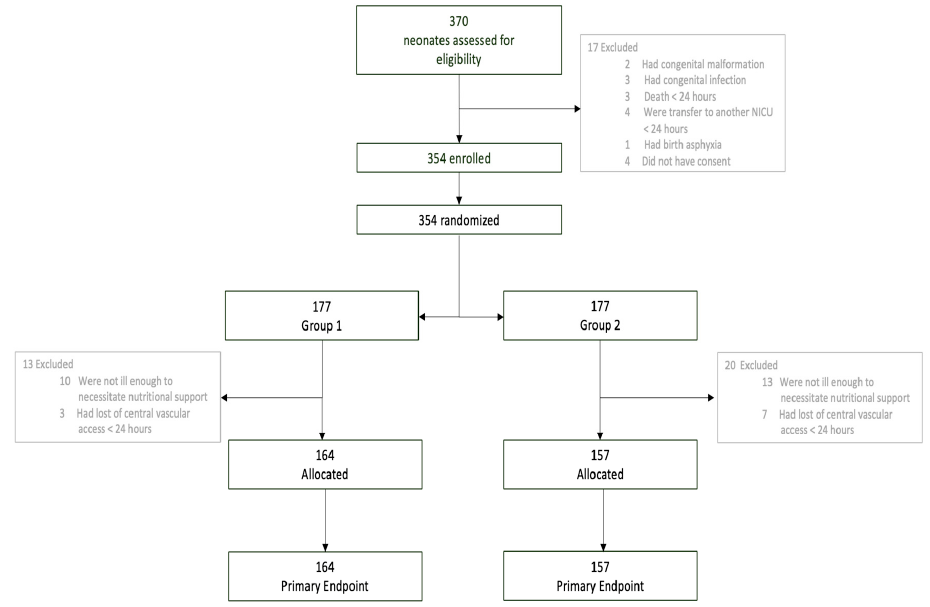
Figure 1. Screening and randomization.